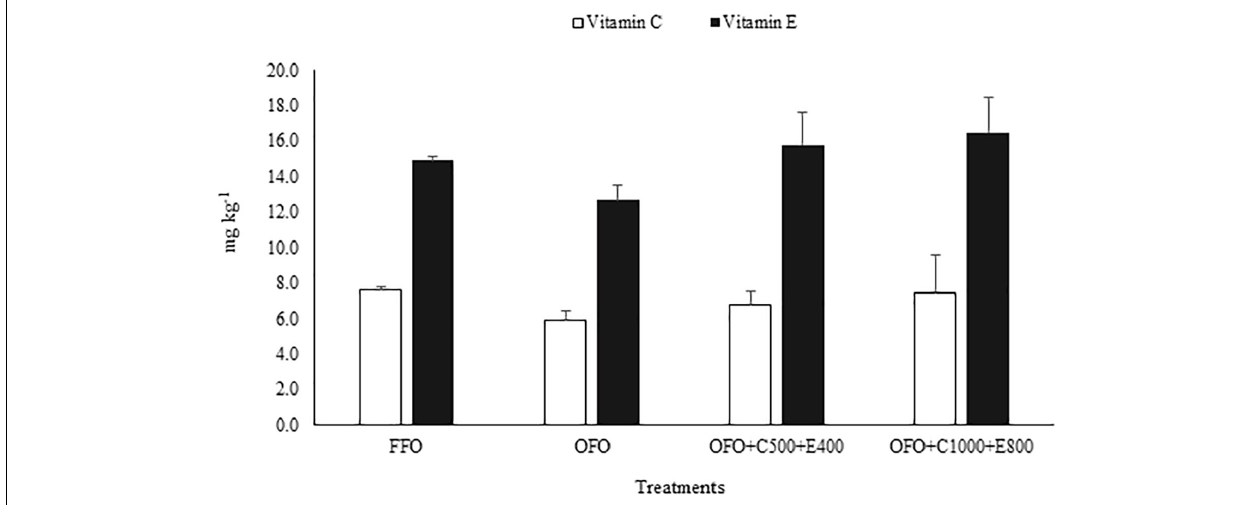
FIGURE 1 | Vitamin C and E concentrations in dorsal muscle of rainbow trout fed fresh fish oil diet (FFO diet), oxidized fish oil containing diet (OFO diet), OFO diet supplemented with 500 mg kg − 1 VC and 400 mg kg − 1 VE (OFO+C500+E400) or 1,000 mg kg − 1 VC and 800 mg kg − 1 VE (OFO+C1000+E800) for 10 weeks. No significant difference was found among